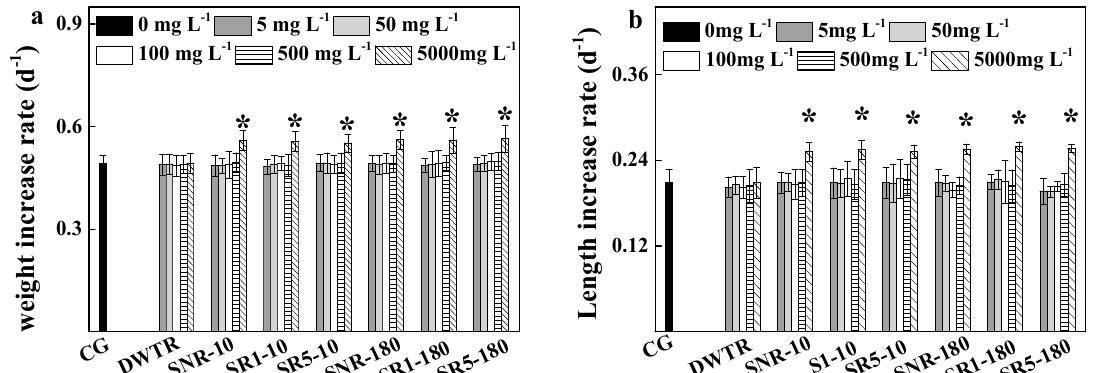
Figure 1. Weight increase rate ( a ) and body length increase rate ( b ) of D. magna . * Above the columns represents statistical significance ( p < 0.05) between results of the control and the treatments.